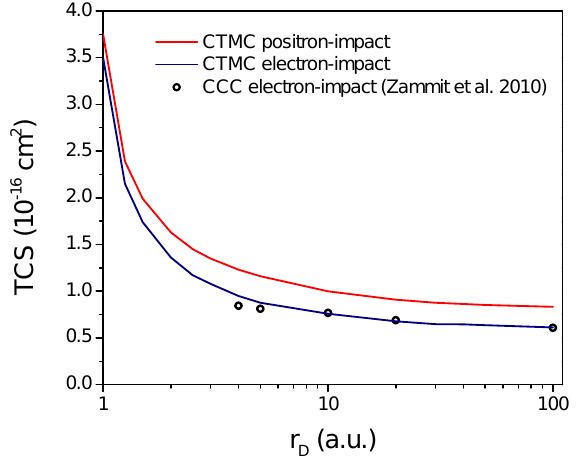
Figure 1. The total ionization cross section as a function of the Debye length r D . The solid curves are the present CTMC calculations and the open circles are the CCC electron impact calculations from Zammit et al. [14].